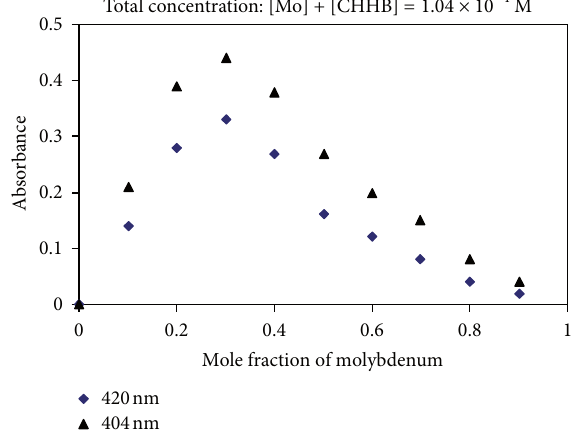
F 1: Job’s method of continuous variations.